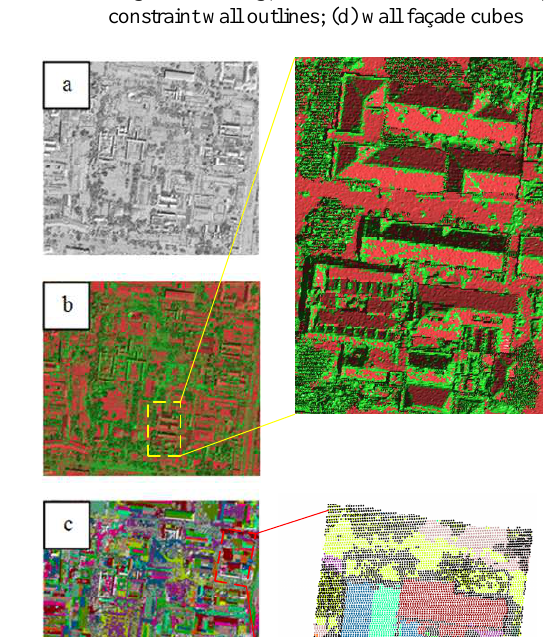
Figure 7. Detection of cubic buildings. (a) point cloud of original building; (b) detected wall outlines; (c) constraint wall outlines; (d) wall façade cubes